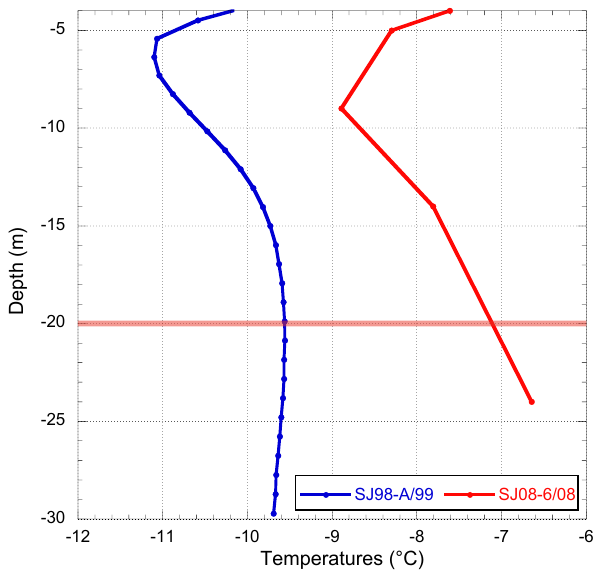
Fig. 10. Temperatures profiles measured in the deep boreholes CG82-1/82 (Haeberli and Funk, 1991), CG95-1/97 and CG95-2/97 (L¨uthi, 2000), CG03-1/03 (Schwerzmann, 2006) and CG05-1/07 (this